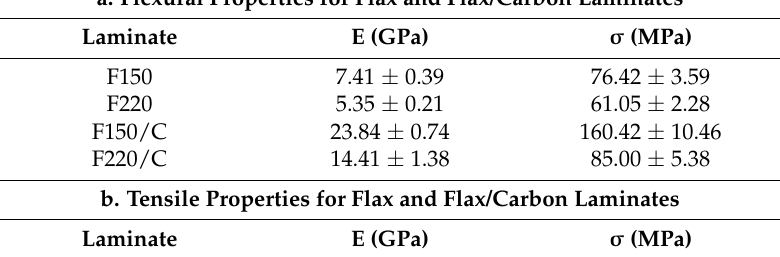
Table 5. The ( a ) flexural and ( b ) tensile properties for flax and flax/carbon laminates. (from data supplied from authors of [37]).